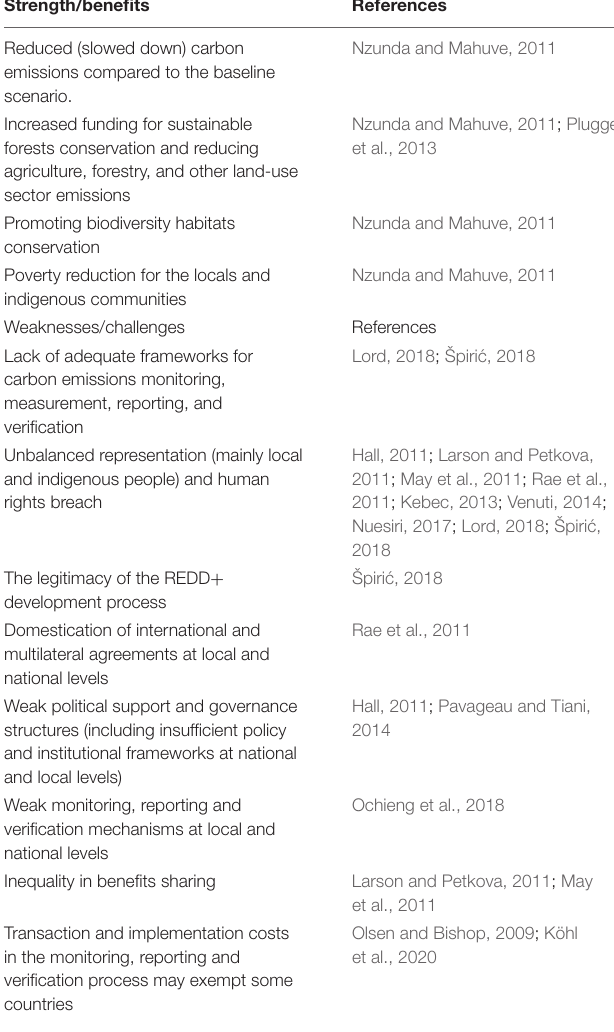
TABLE 6 | Strengths and weaknesses associated with REDD +